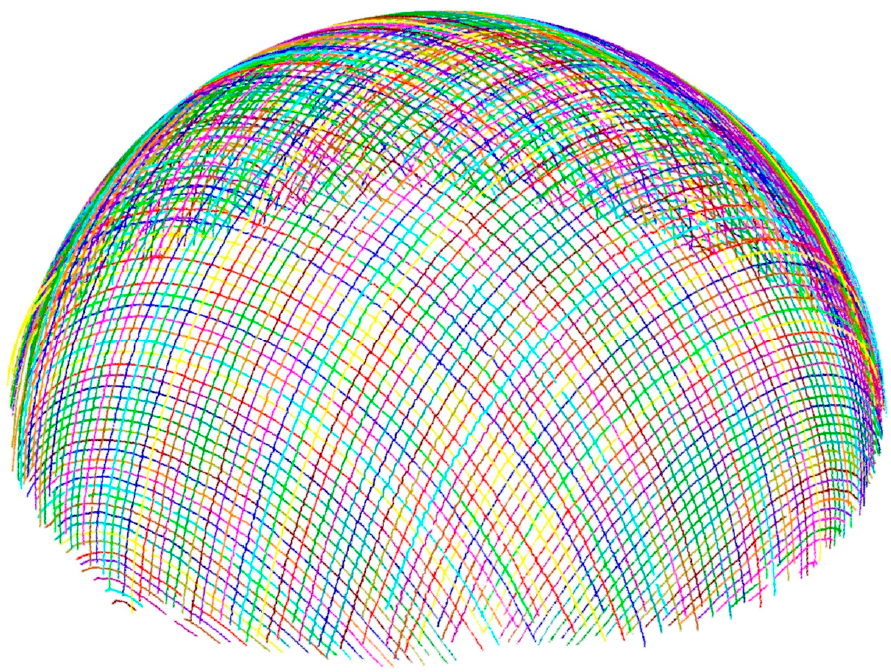
Figure 8. Overall reconstruction result.